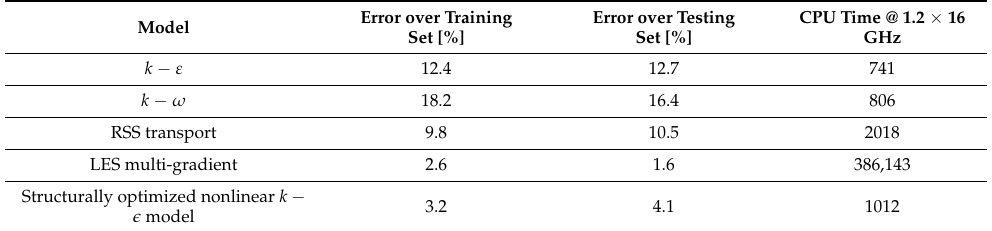
Figure 8. Contour plots of the streamwise velocity at Re = 1111 using different methods. ( a ) Laminar flow simulation; ( b ) k − (cid:101) model; ( c ) k − ω model; ( d ) Reynolds Shear Stress transport model; ( e ) Structurally optimized k − (cid:101) model; ( f ) LES multiple-gradient model; ( g ) time-averaged DNS results. Table 4. Errors and computation time of each turbulence model for the High Aspect Ratio Backward Facing